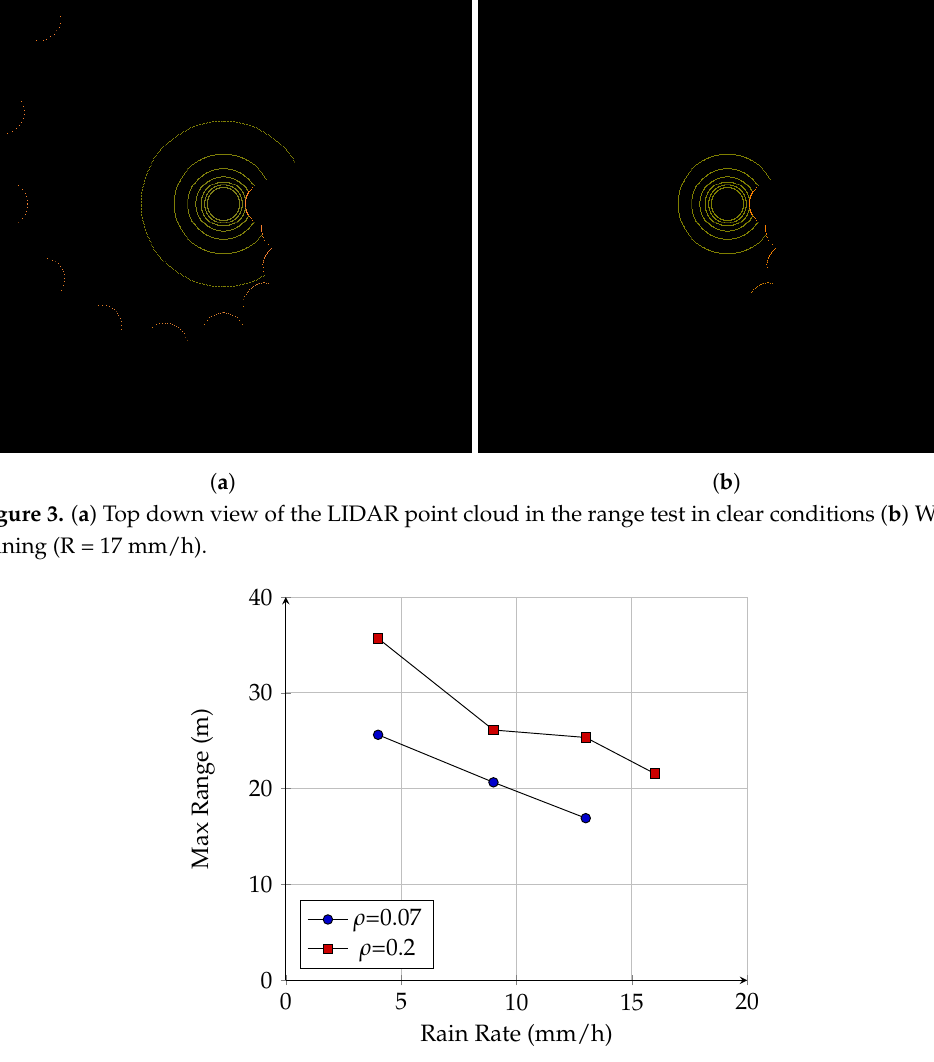
Figure 4. Decrease in max range for a simulated LIDAR as a function of rain